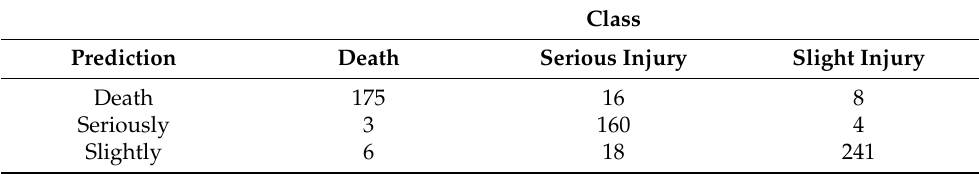
Table 5. Confusion matrix for the random forest.